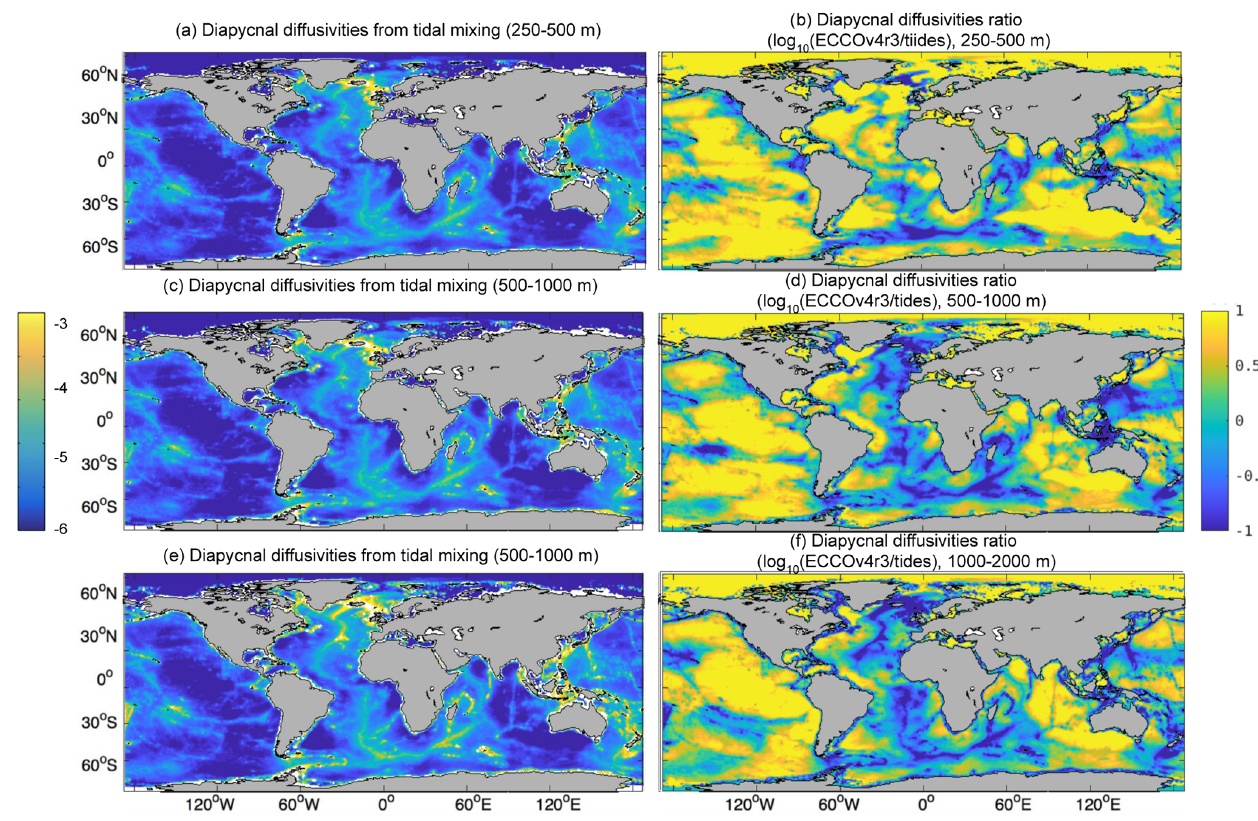
Figure 7. Shown are (a , c , and e) the base-10 logarithms of κ ρ, tides (units in m 2 s − 1 ) and (b , d , and f) the base-10 logarithms of the ratios of the time-averaged κ ρ, ECCO to κ ρ, tides . Panels (a) and (b) show an average over 250–500m depth. Panels (c) and (d) show an average over 500–1000m depth. Panels (e) and (f) show an average over 1000–2000m